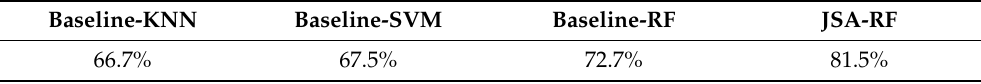
Table 2. Sound classification result based on the SA features and RF